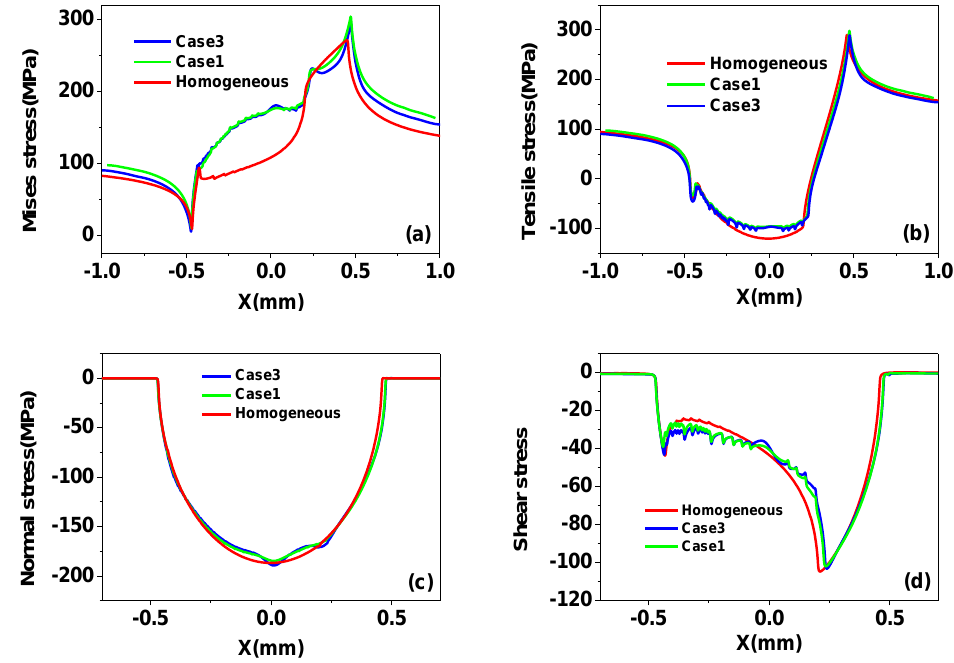
Figure 16. ( a ) Mises stress, ( b ) tensile stress, ( c ) normal stress, ( d ) shear stress distribution on the contact surface for different inclusion materials cases.